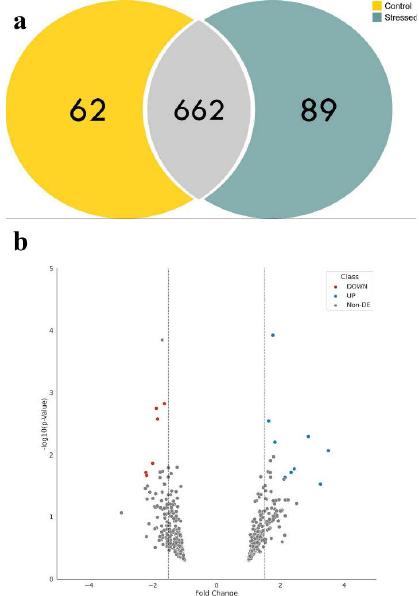
Figure 3. Summary of the proteomics analysis performed on the leaves of young oil palm plants under salinity stress using the PatternLab for Proteomics V software. ( a ) Control and stressed conditions shared 662 protein identifications; 62 and 89 proteins were uniquely detected in control and stressed samples, respectively; ( b ) volcano plot of the differentially abundant proteins reported by Pattern Lab’s T Fold module, where 20 proteins showed statistically significant differences in their abundance—proteins in blue were significantly up-regulated while the ones in red were significantly down-regulated between stressed and control samples.